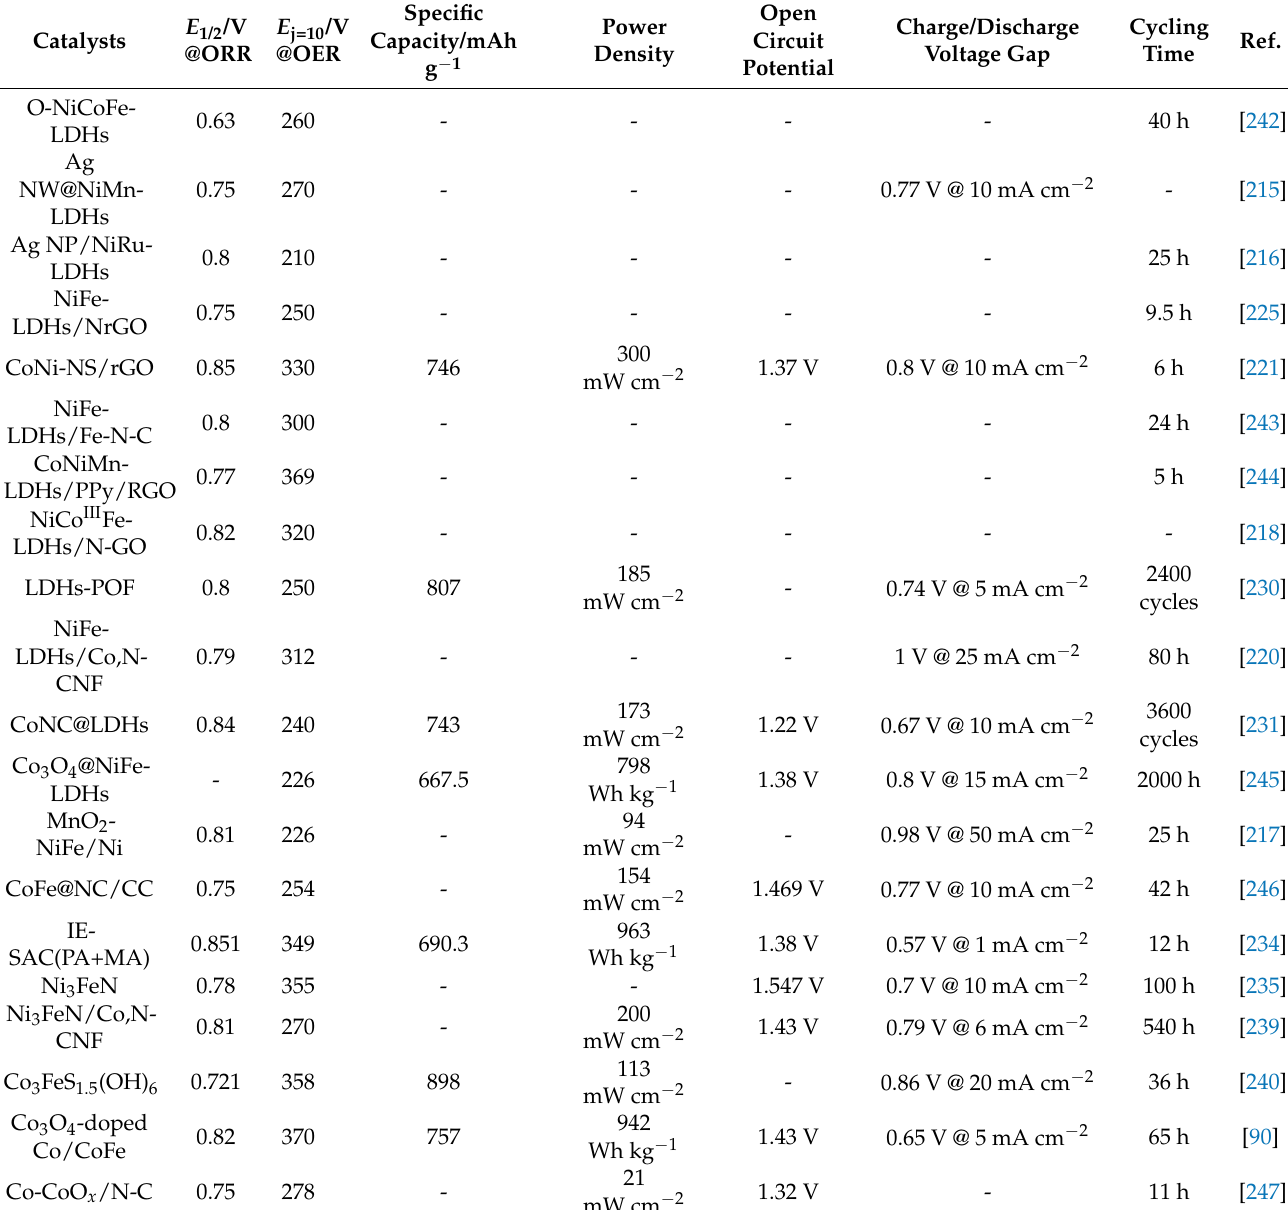
Table 2. The bifunctional performances of LDHs-based materials in alkaline